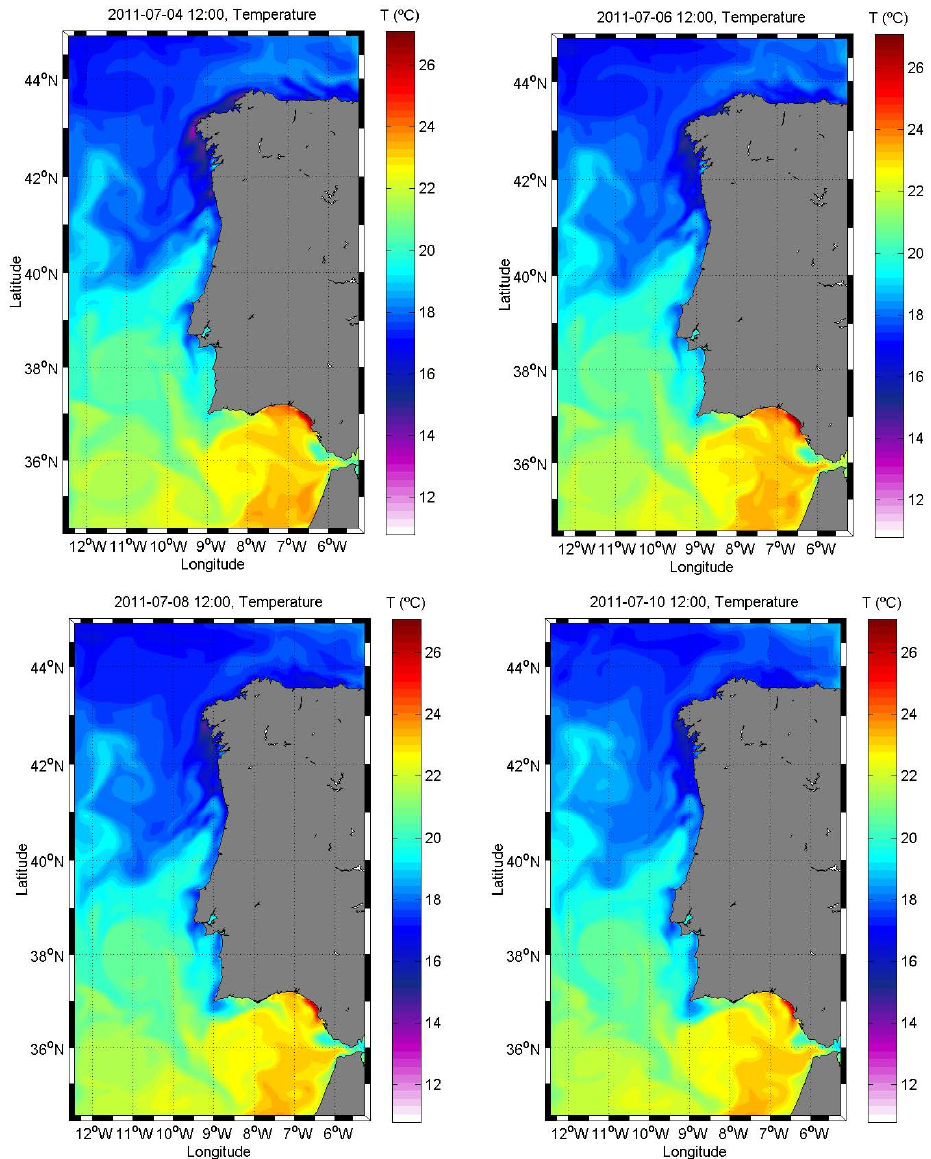
Fig. 5. Snapshots of sea surface temperature predicted by the model from 4 to 10 July